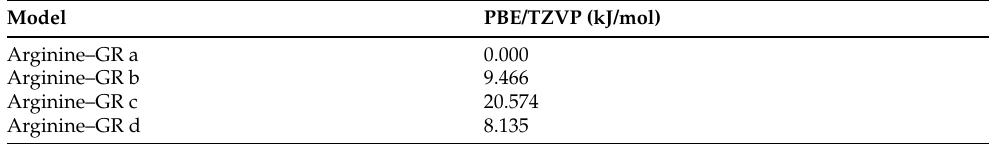
Figure 2. Selected folded conformers of arginine–GR. [H = white, C = grey, N = blue, and O = red]. ( a ) Arginine–GR a; GL interacting with GR with a carboxylic acid group. ( b ) Arginine–GR b; GL interacting with GR with an amine group. ( c ) Arginine–GR c; GL interaction with GR in a horizontal way. ( d ) Arginine–GR D; GL interaction with GR in a horizontal way. Table 1. Arginine–GR complexes energies as displayed in Figure